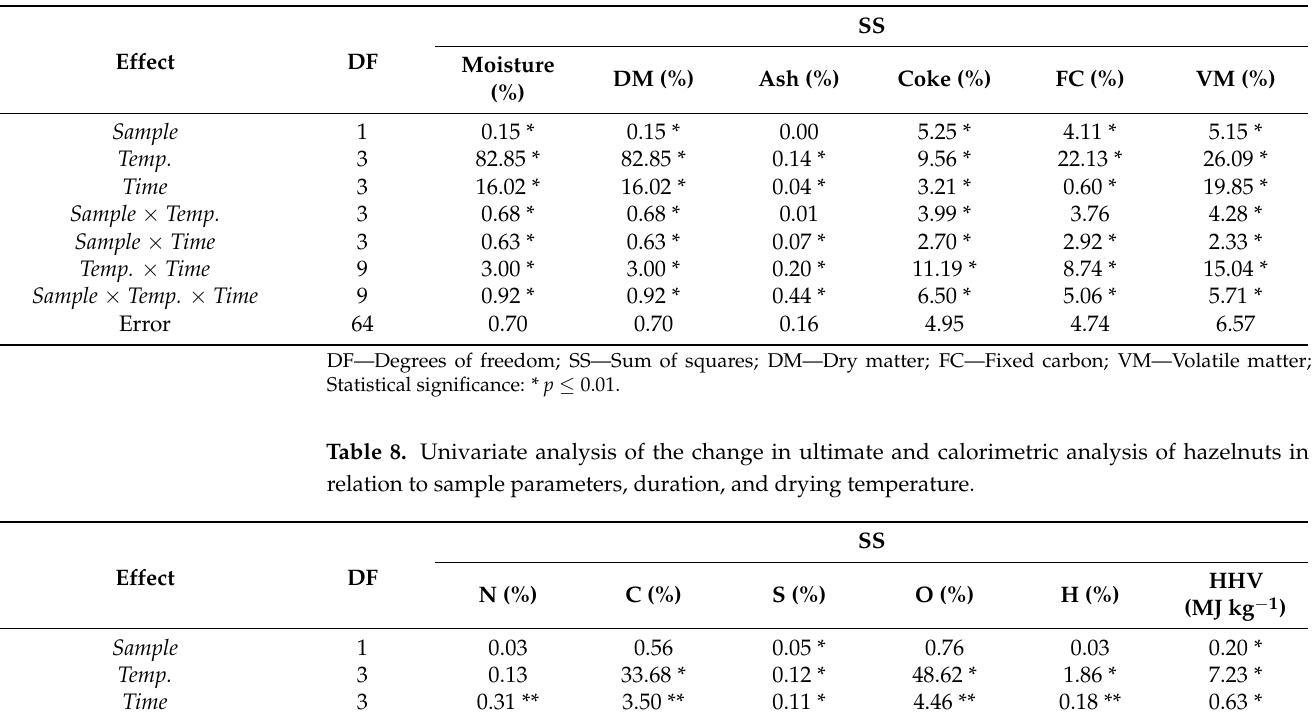
Table 7. Univariate analysis of the change in proximate analysis of hazelnuts in relation to sample parameters, drying time, and temperature.